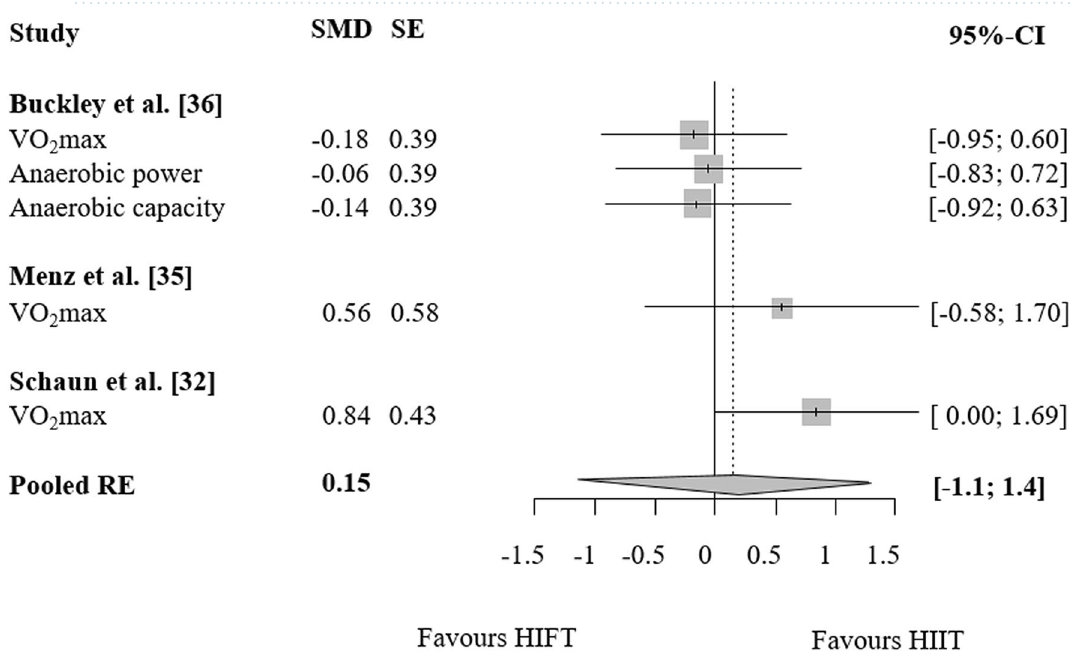
Figure 6. Effects of high-intensity-functional training (HIFT) vs. high-intensity interval training (HIIT) on markers of endurance. Forest plots with pooled standardized mean differences (SMD), standard errors (SE) and 95% confidence intervals (CI) are displayed. RE random